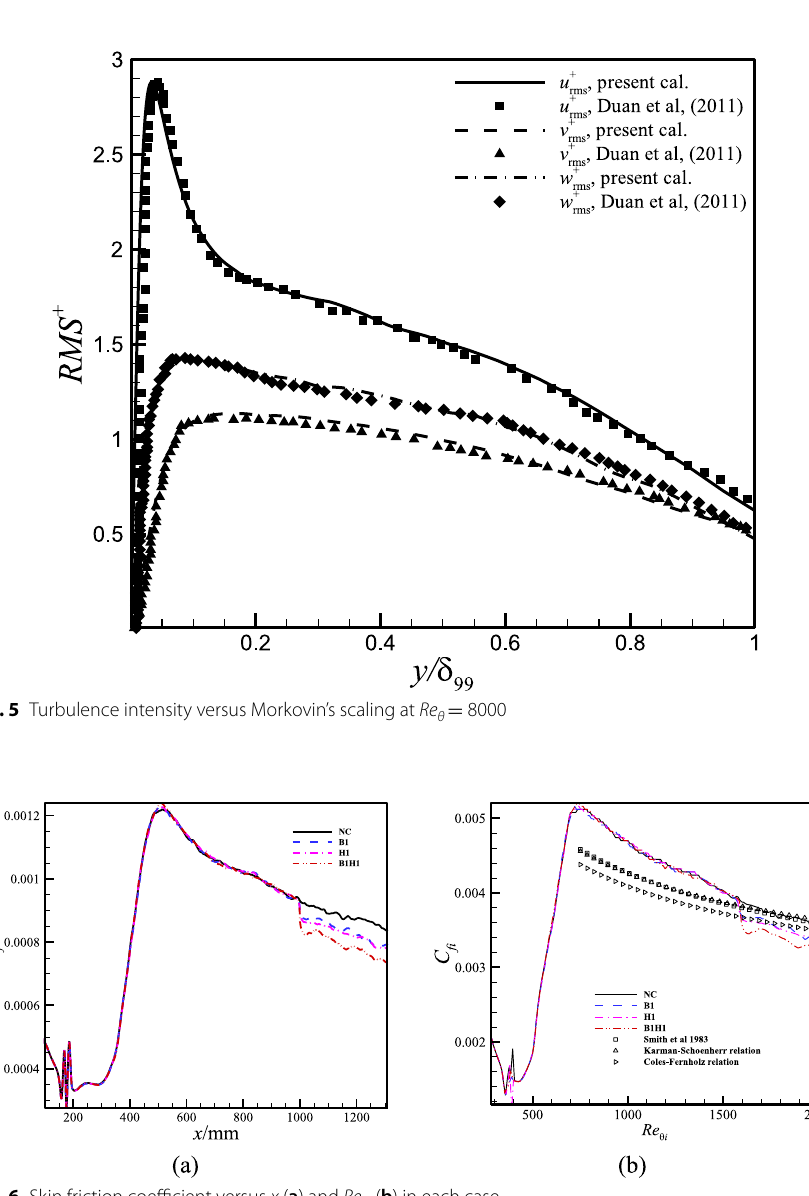
Fig. 6 Skin friction coefficient versus x ( a ) and Re θi ( b ) in each